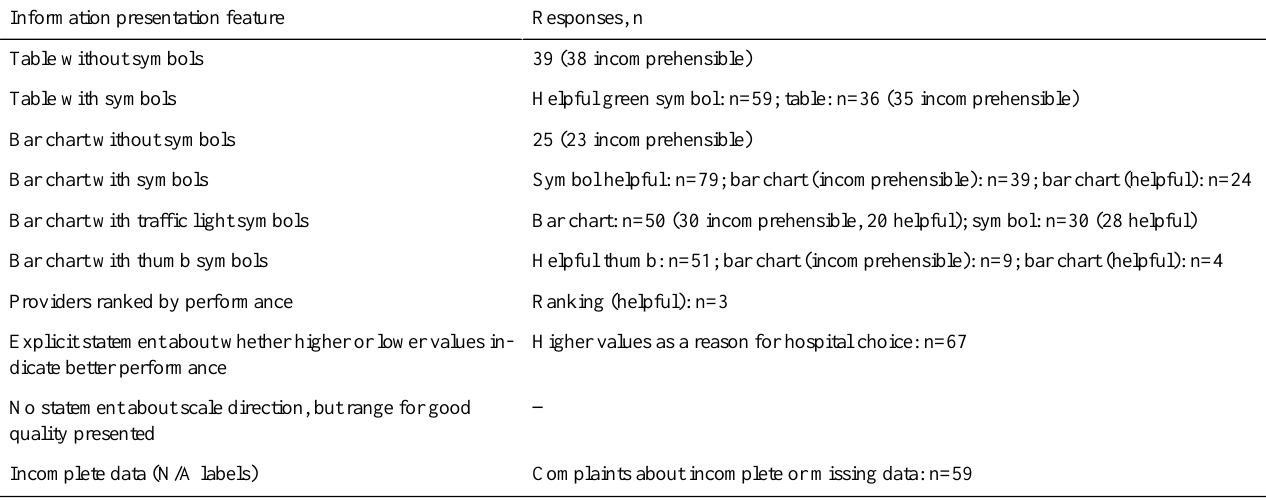
Table 6. Responses to the open-ended question about information presentation.